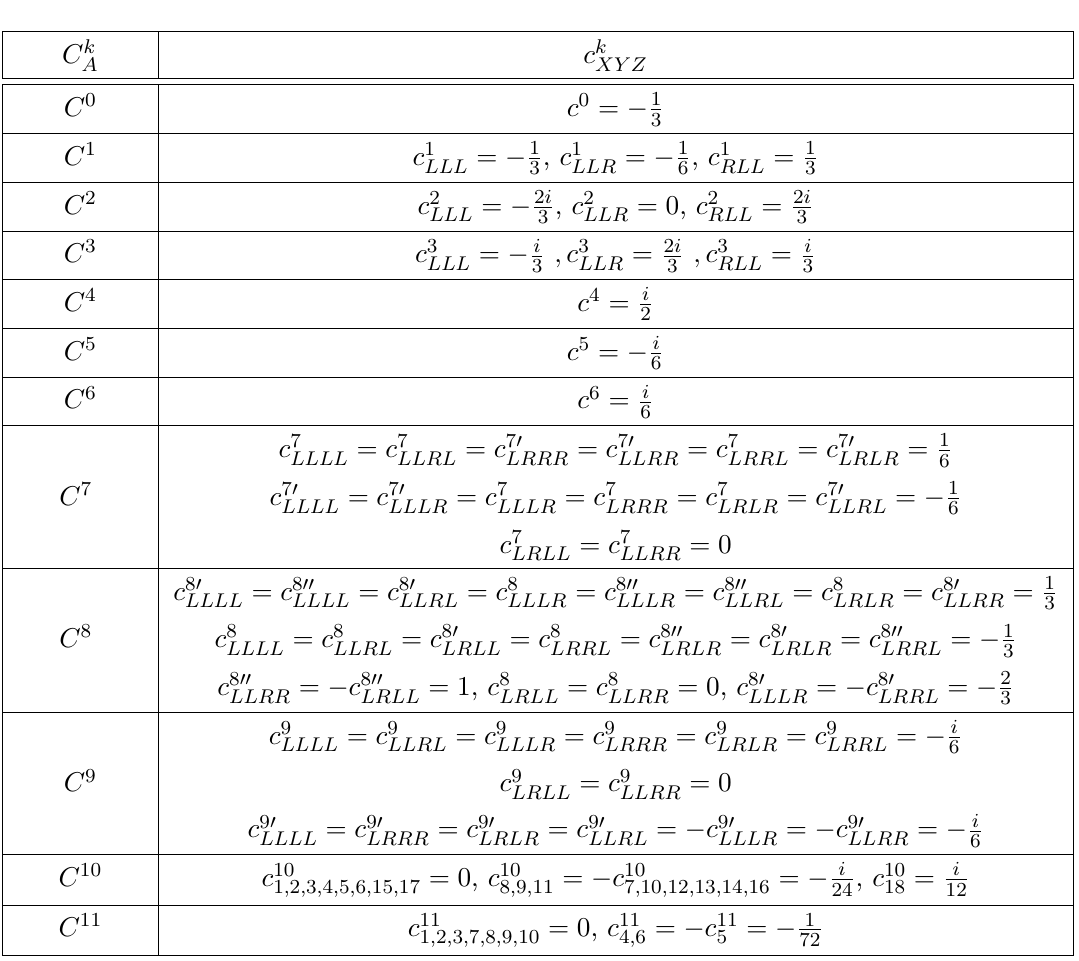
Table 5 . Explicit results at one loop in DR for the coefficients c k entering the C k introduced in section 3.1, in units of 1 / (16 π 2 )